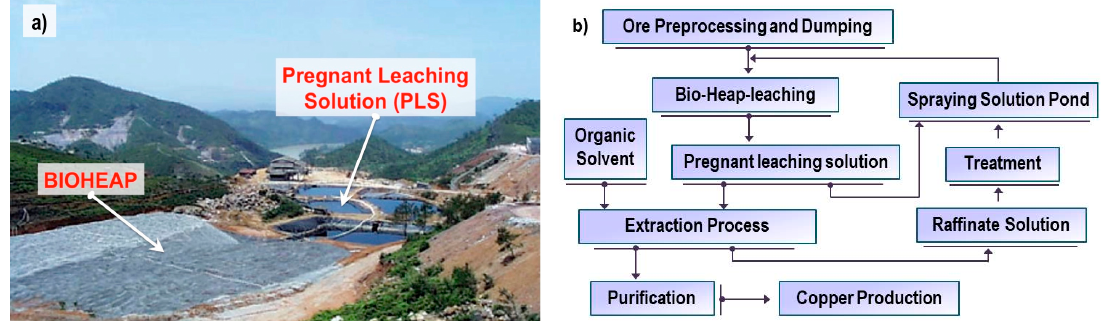
Figure 3. Heaps and technological process of ZCM. ( a ) Overall view of bioheap plants in Zijinshan Copper mine; ( b ) Basic flowchart of bioheap leaching system.